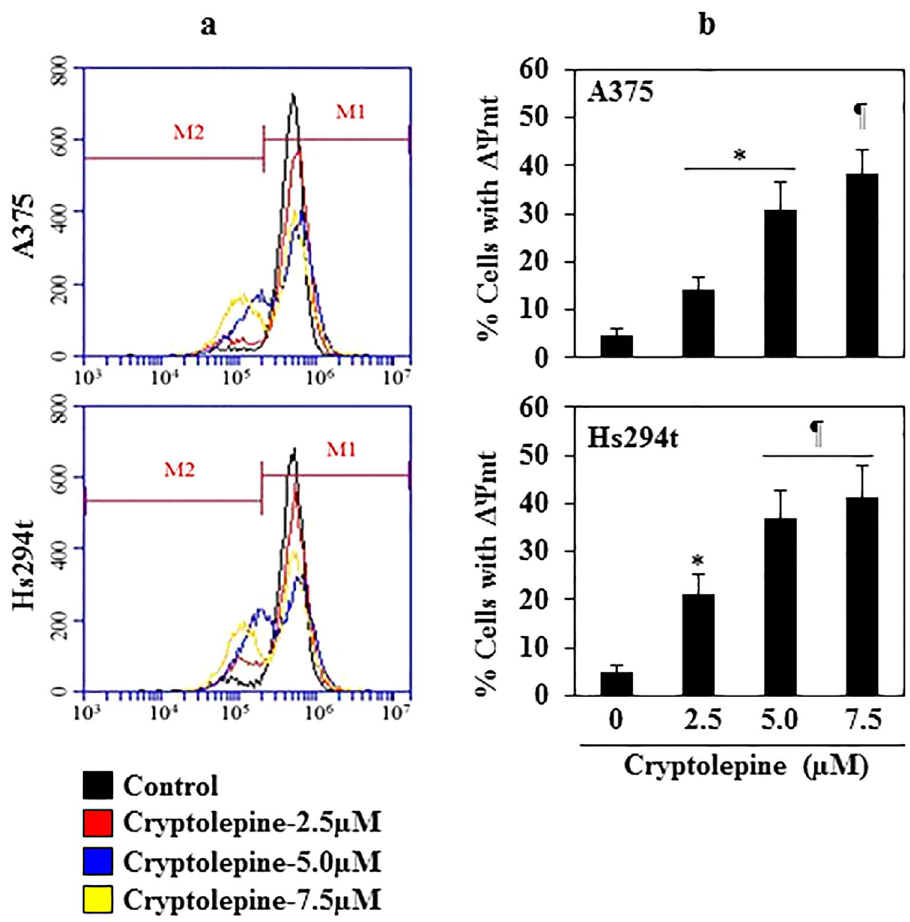
Figure 2. Treatment with cryptolepine disrupts mitochondrial membrane potential in melanoma cells. ( a ) Representative melanoma cell lines (A375 and Hs294t) were treated with various concentrations of cryptolepine (0, 2.5, 5.0 and 7.5 µ M) for 24 h. Thereafter, cells were harvested, incubated with Rhodamine 123 and then analyzed for loss of mitochondrial disruption using flow cytometry. Data were compared with non- cryptolepine-treated cells. Treatment groups are shown in color. (b) Percentage of cells with mitochondrial disruption in different treatment groups was determined. The resultant data are presented in terms of the percentage of cells with loss of mitochondrial membrane potential and as means ± SD, n = 3. Statistical difference versus control, * P < 0.05 and ¶ P <